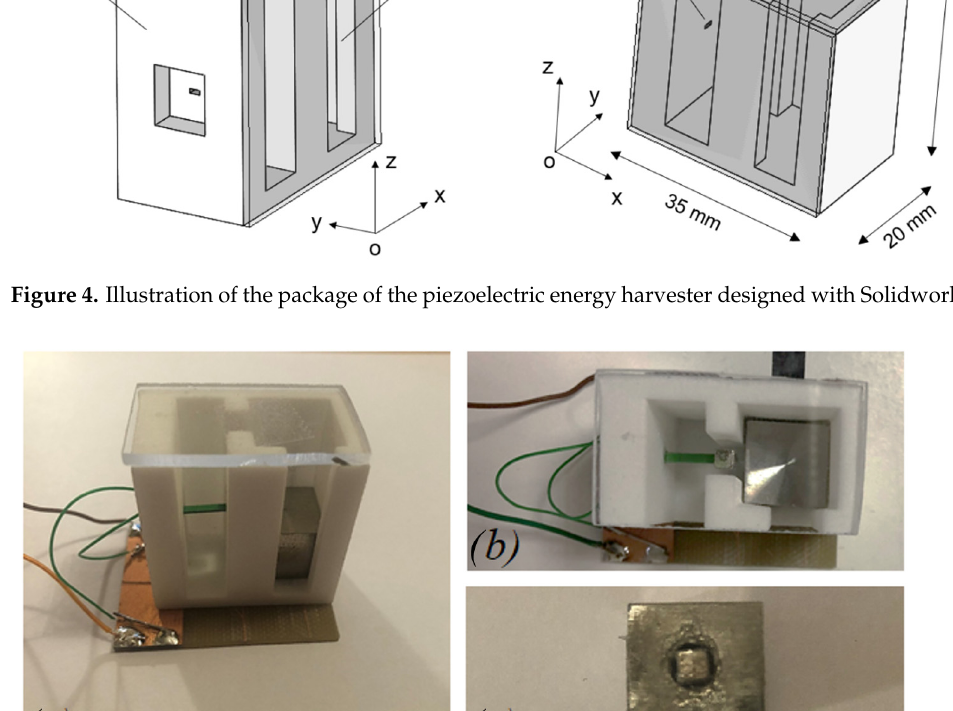
Table 1. Physical parameters and dimensions of the piezoelectric beam.